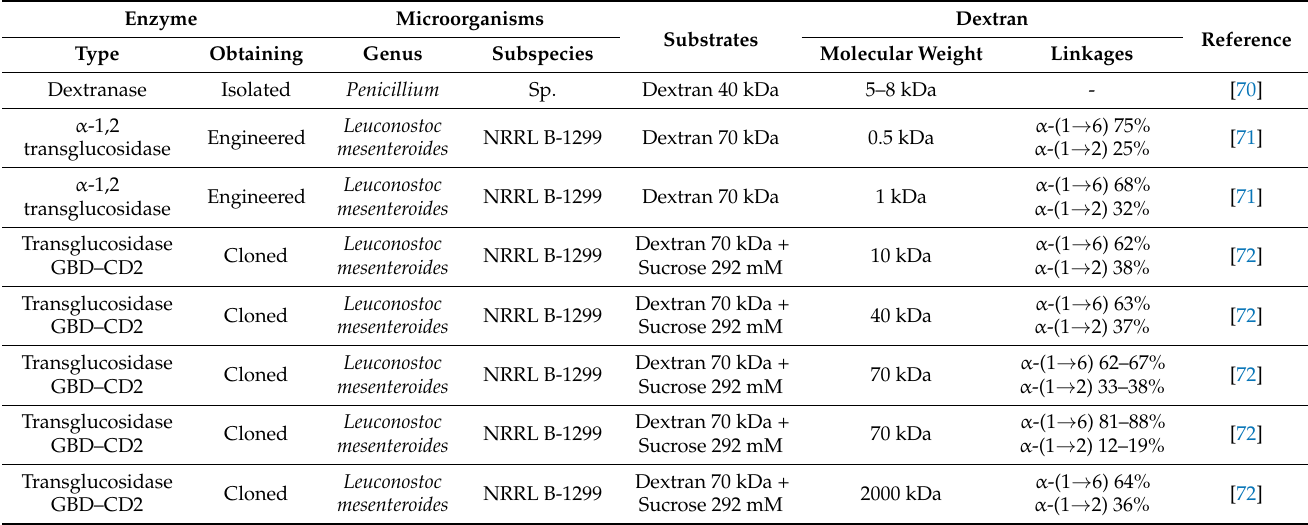
Table 3. Dextrans synthesized by hydrolysis